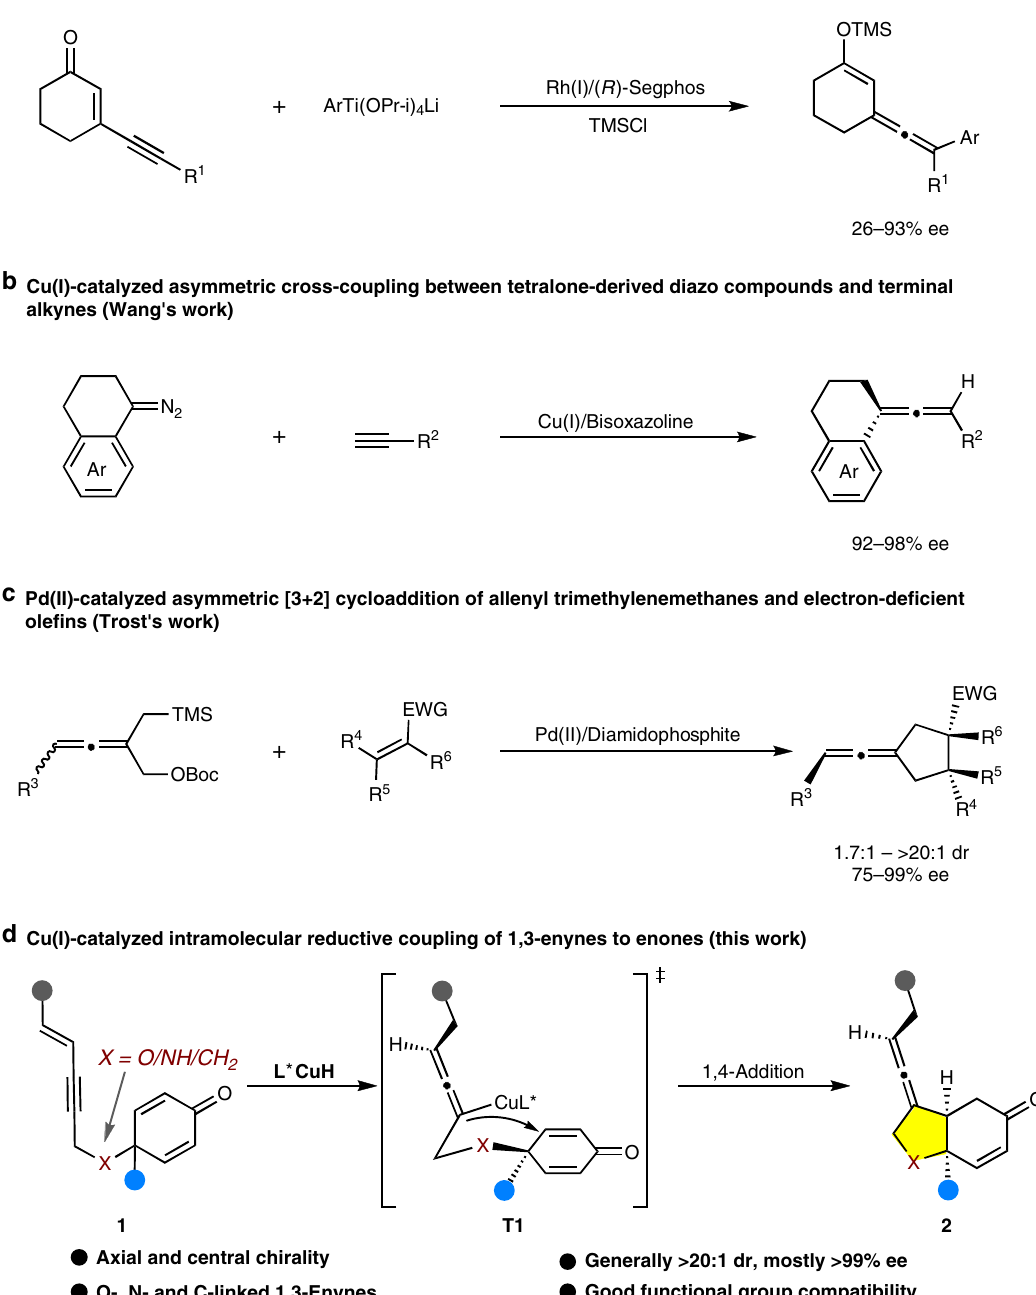
Fig. 2 Strategies for synthesis of chiral exocyclic allenes. a – c Previous works on synthesis of chiral exocyclic allenes. d This work: Cu(I)-catalyzed intramolecular reductive coupling of 1,3-enynes to